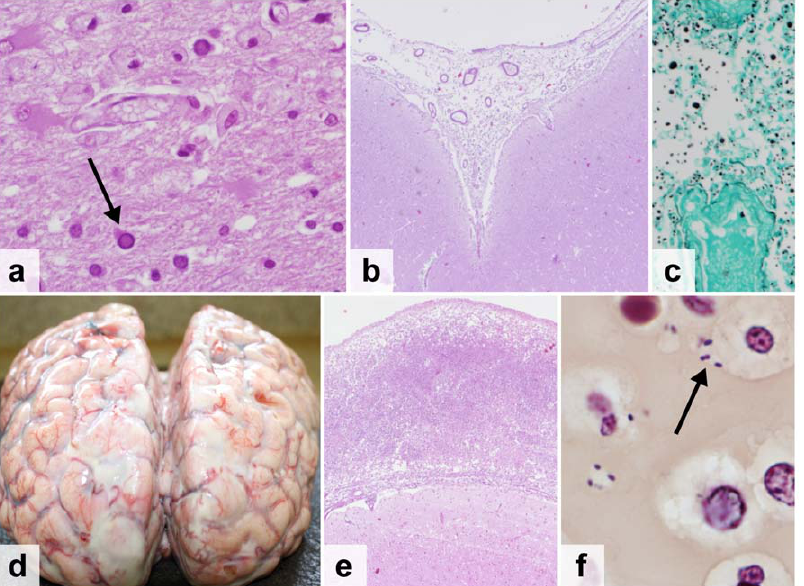
Figure 5. Central nervous system infections. a. Progressive Multifocal Leukoencephalopathy due to JC-virus infection, showing viral inclusion (arrow) and loss of myelin (H&E stain) b–c. Cryptococcal meningitis, showing Cryptococcus neoformans with a polysaccharide capsule (H&E stain)(b) and multiple narrow-necked budding yeast (Grocott Methanamine Silver stain) (c) d–f. Streptococcal meningitis, showing the macroscopic image of the brain with edema and purulent exudate (d), the subarachnoid space expanded by neutrophils and fibrin (H&E stain) (e) and Gram positive diplococci (arrow) (Brown-Hopps tissue Gram stain) (f).